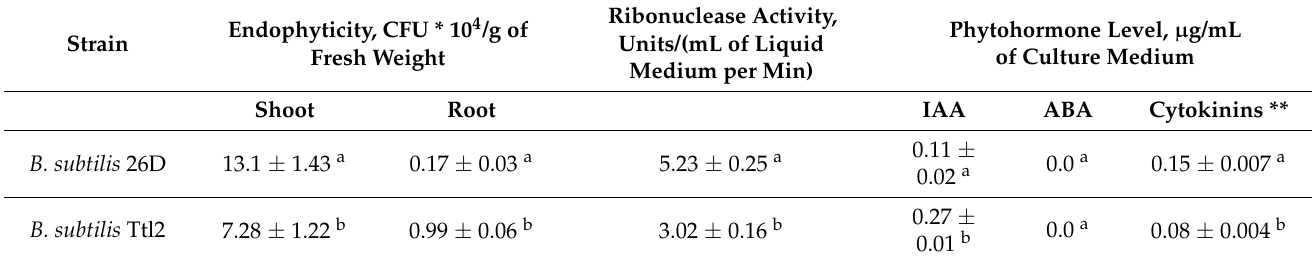
Table 1. CFU content in the internal tissues of potato, the ribonuclease activity in vitro and the content of phytohormones in the culture medium of strains B. subtilis 26D and B. subtilis Ttl2. Ribonuclease Activity, Phytohormone Level, µ g/mL Units/(mL of Liquid of Culture Medium Medium per Min)